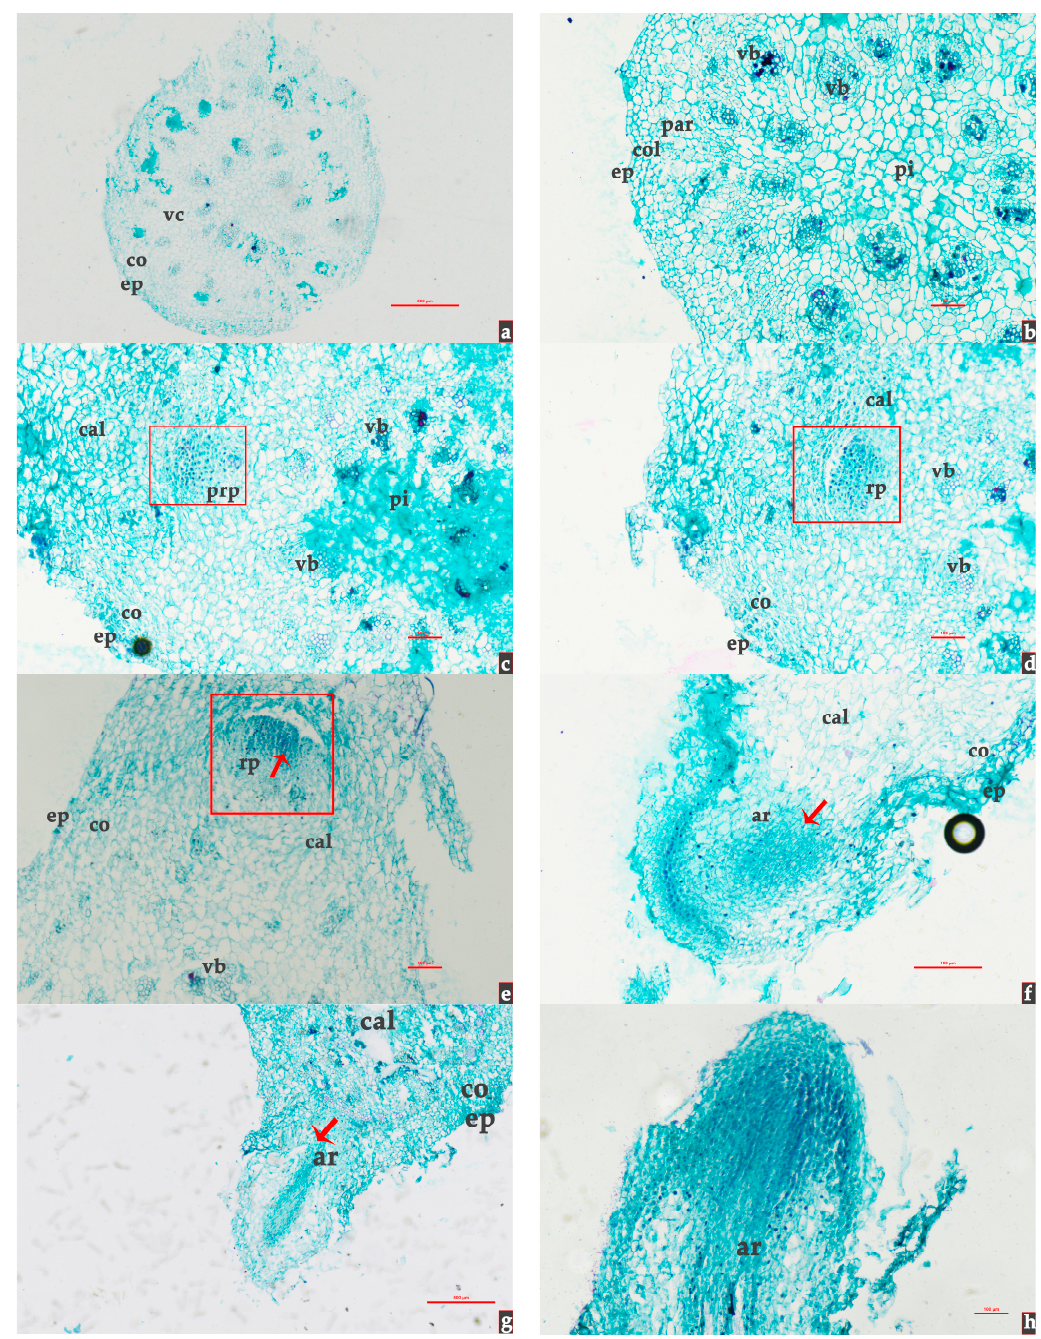
Figure 2. Anatomical analysis of in vitro rooting of B. buttiana ‘Miss Manila’. ( a ) Histological structure on Day 0. ( b ) Histological structure on Day 5. ( c ) Histological structure on Day 10. The parenchyma cells of the basic tissue continuously proliferate and form callus tissue. ( d ) Histological structure on Day 15. Root primordia were gradually formed in the callus ( e ) The differentiated root primordia continuously pushed outward in the cortex. ( f ) Adventitious roots, formed from root primordia, penetrated the cortex and callus. ( g ) The adventitious roots pass through the epidermis and form roots vascularly connected with the stem. ( h ) Constant elongation of adventitious roots. The red frame shows precursor cells of adventitious root primordia and root primordium, and the red arrow shows growth direction of root primordium and adventitious root. Abbreviations: ep = epidermis; co = cortex; col = collenchyma; par = parenchyma; vc = vascular cylinder; vb = vascular bundle; prp = precursor of adventitious root primordia; cal = callus tissue; pi =